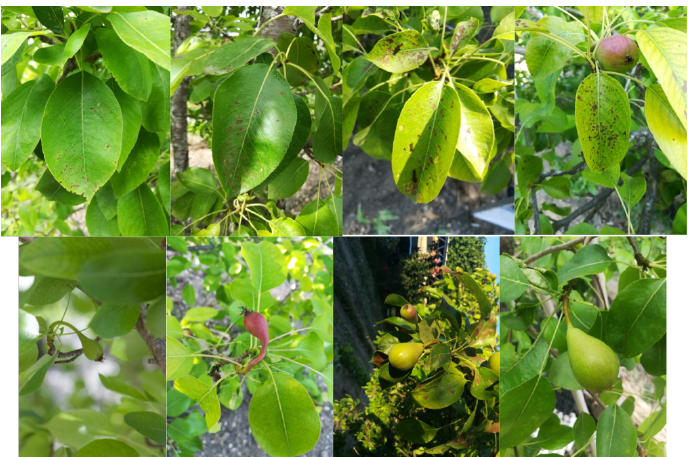
Figure 1. On the first row, from left to the right, images of pear leaves captured under different light conditions: indirect sunlight, direct sunlight, strong sunlight reflection and distributed light. On the second row, images of pear fruit in different stages of